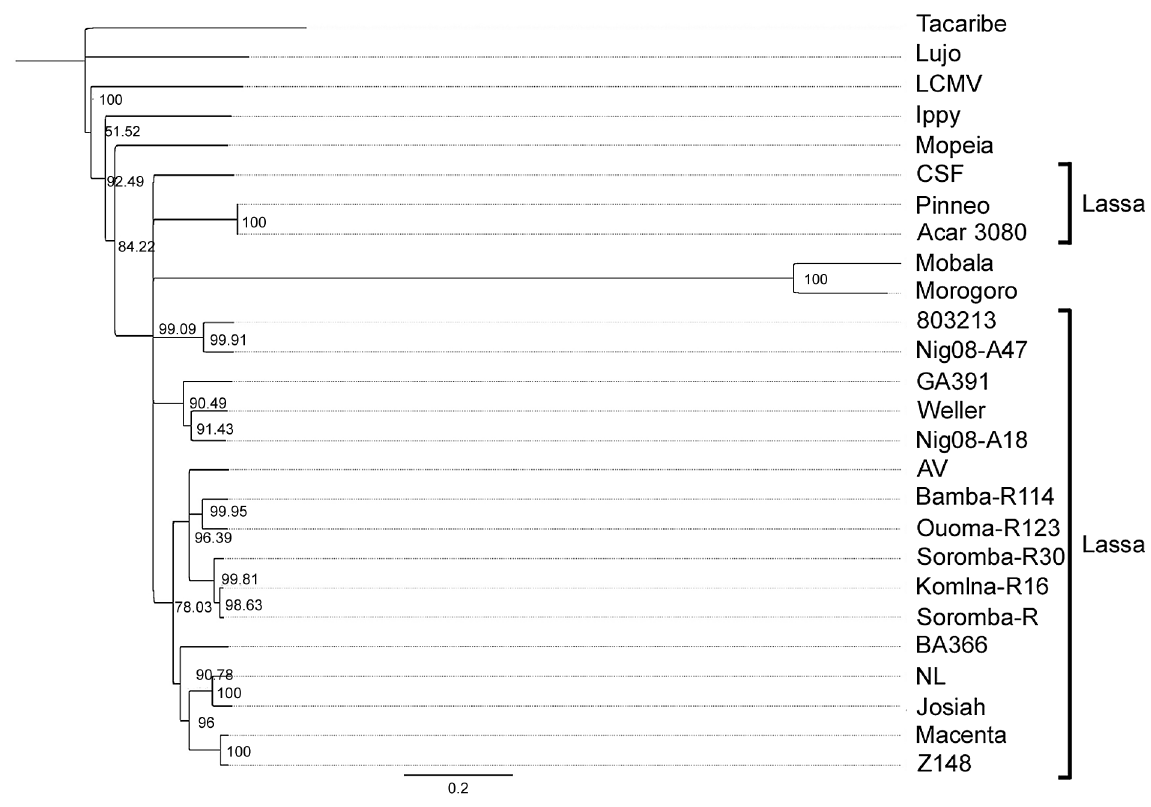
Figure 2. Phylogenetic analysis was conducted on full-length sequences for the nucleocapsid protein using the Jukes-Cantor Neighbor-joining method with 10,000 bootstrap replicates. Sequences from the five Malian isolates were compared to the following arenavirus sequences: Tacaribe (NC_004293), Lujo (NC_012776), Lymphocytic choriomeningitis virus (LCMV, strain Armstrong, AY847350), Ippy (NC_007905), Mobala (AY342390), Morogoro (NC_013057), Mopeia (NC_006575) and Lassa virus strains Josiah (AY628203), CSF (AF333969), NL (AY179173), AV (AF246121), Z148 (AY628205), Macenta (AY628201), BA366 (GU830839), Nig08-A18 (GU481070), Nig08-A47 (GU481078), 803213 (AF181854), Pinneo (AY628207), GA391 (X52400), Acar 3080 (AY628208) and Weller (AY628206).